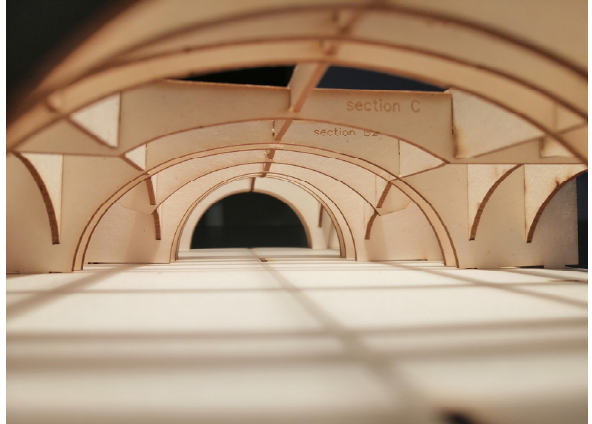
Figure 9. Intradosal view of the physical model of Palazzo Mazzonis atrium. Digital prototyping: F. Ronco.